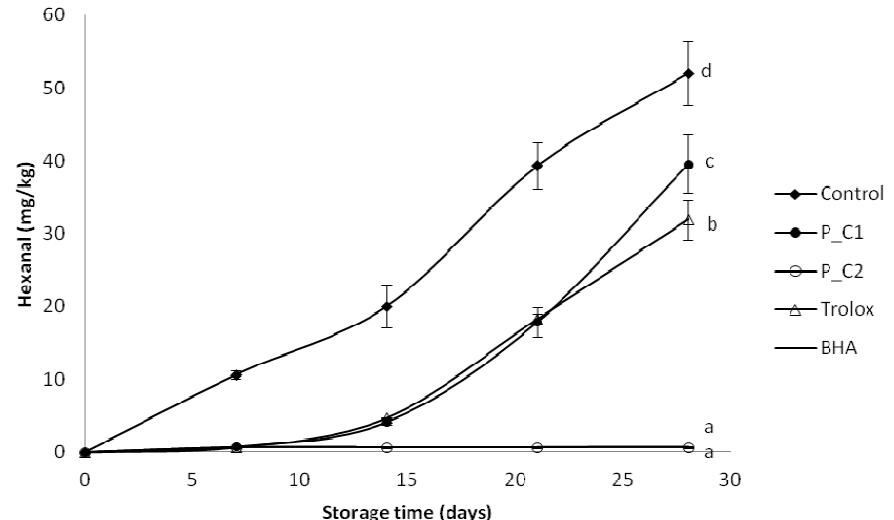
Figure 4. Evolution of secondary oxidation (hexanal content) in model food system (O/W emulsion 10% of oil) with different concentration of perilla ethanolic extracts (C1: 80 ppm and C2: 320